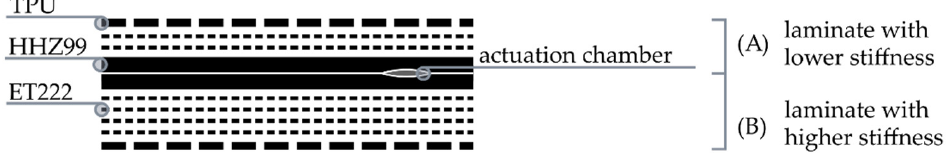
Figure 3. Schematic of an exemplary laminate set-up (TPU/ET222 4 /HHZ99 2 /ET222 2 /TPU), where ET222 is implemented with a fiber orientation of ±45°.